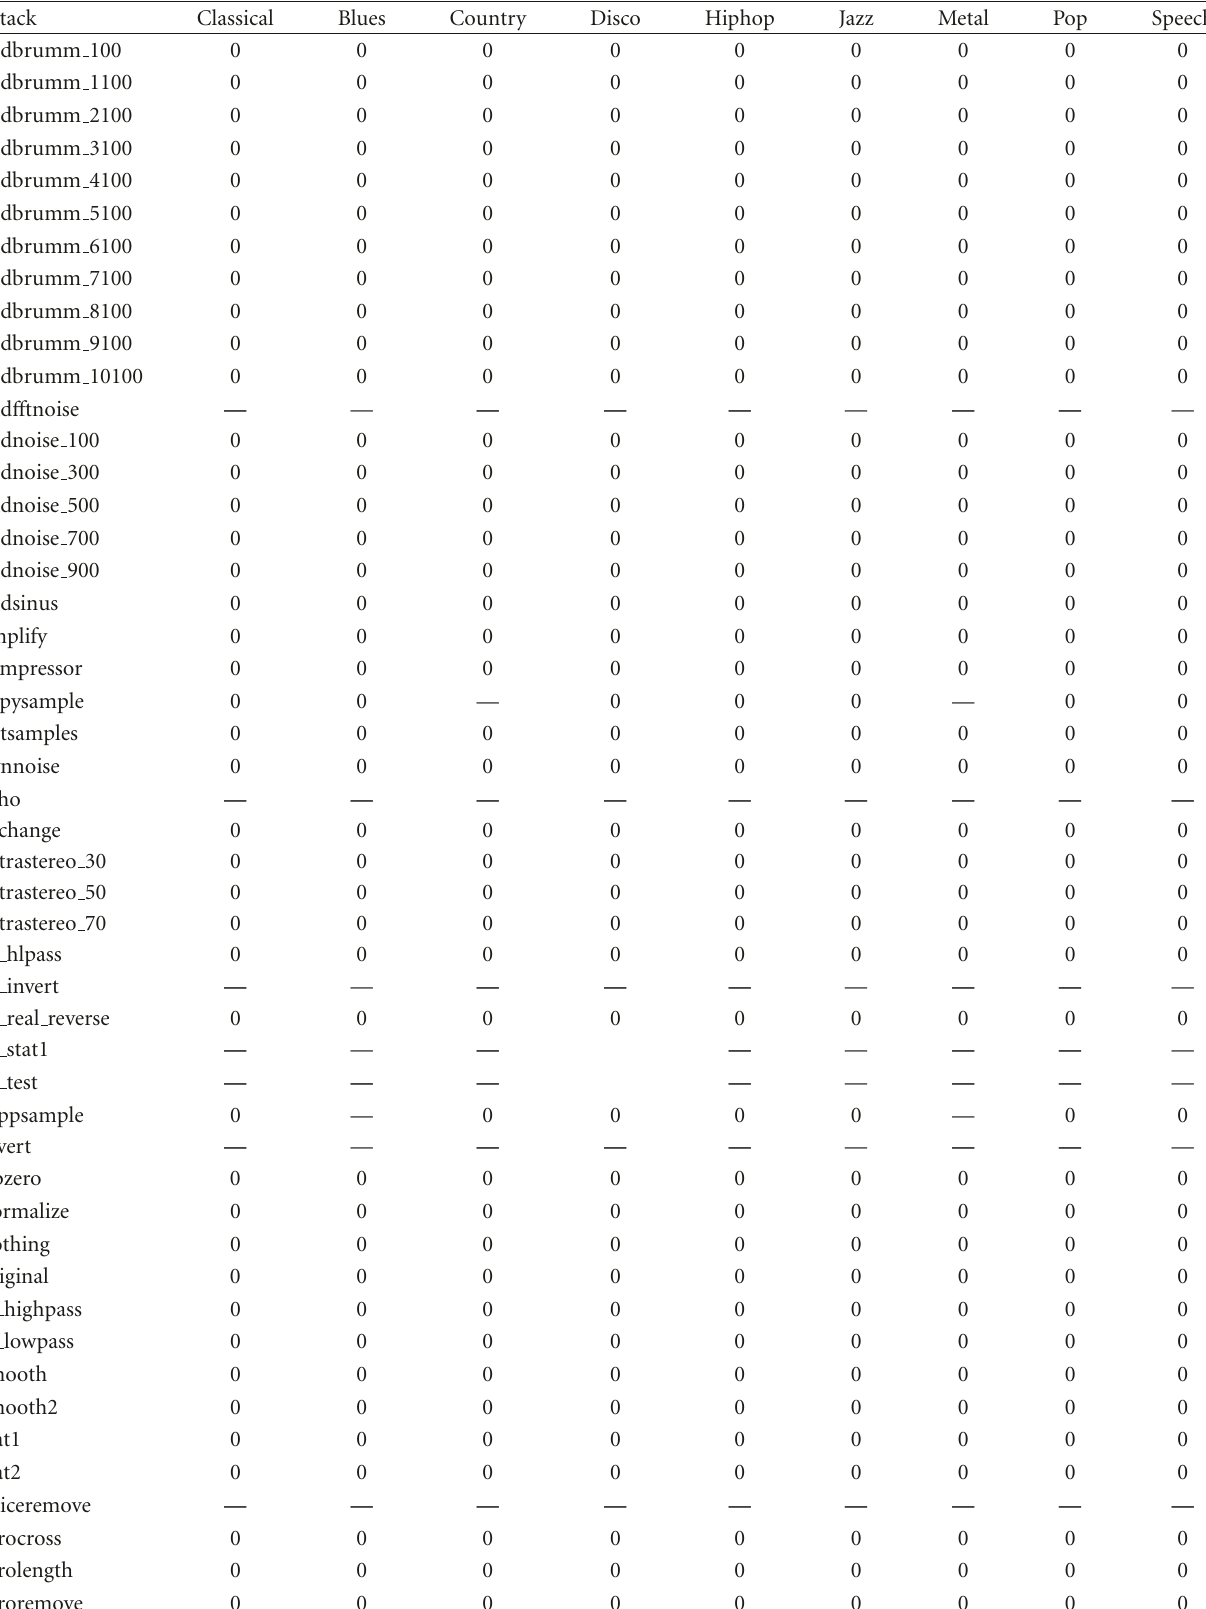
Table 2: Robustness to Stirmark attacks (Watermark length =